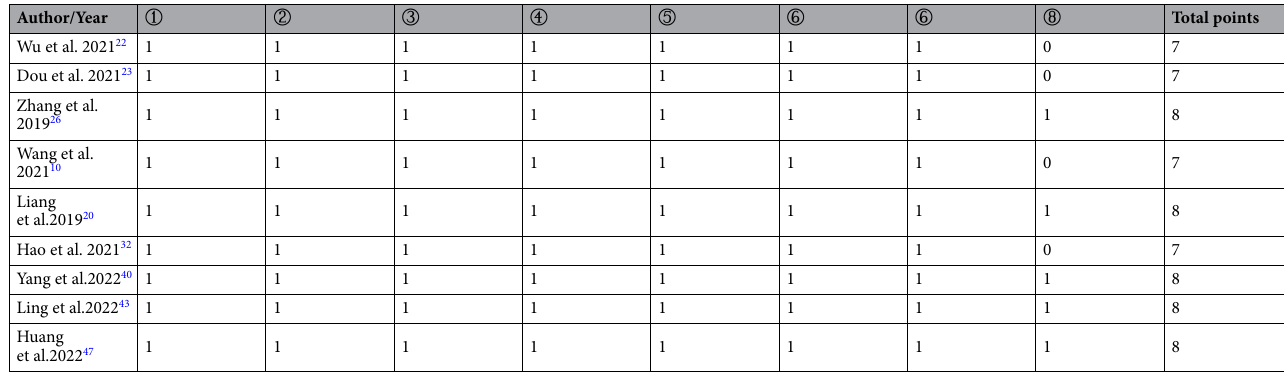
Table 3. Quality assessment of included studies using the Newcastle Ottawa Scale checklist. ① Adequacy of case definition ② Number of cases ③ Representativeness of the cases ④ Ascertainment of relevant cancers ⑤ Ascertainment of detection method ⑥ CircRNA expression ⑦ Assessment of outcome ⑧ Adequate